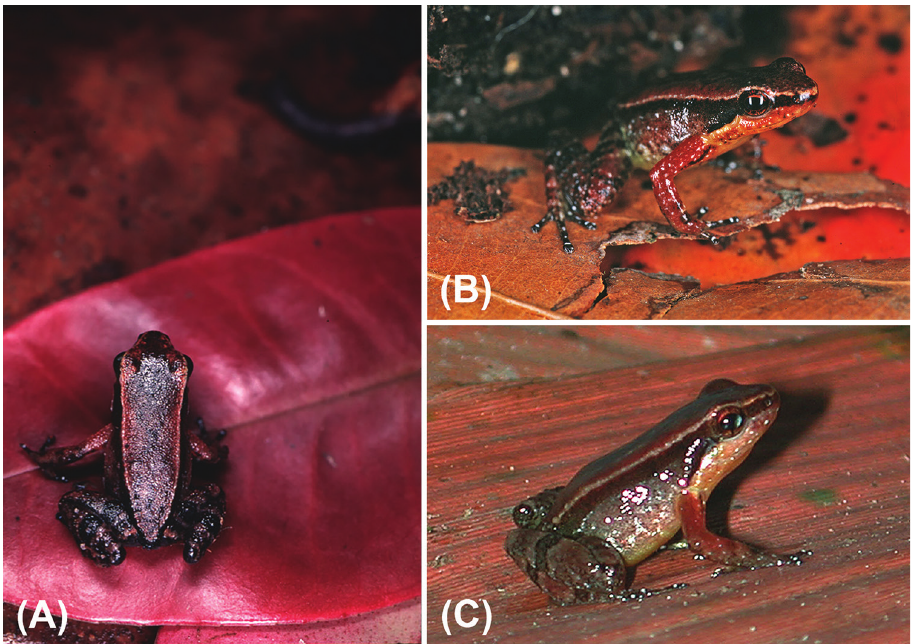
Figure 4. Anomaloglossus meansi sp. n. in life. A female paratype ROM 43332, dorsal view B female para- type ROM 43329, dorsolateral view C male paratype CPI 11000, dorsolateral view. Photographs ( A, B ) by AL; photograph ( C ) courtesy D. Bruce